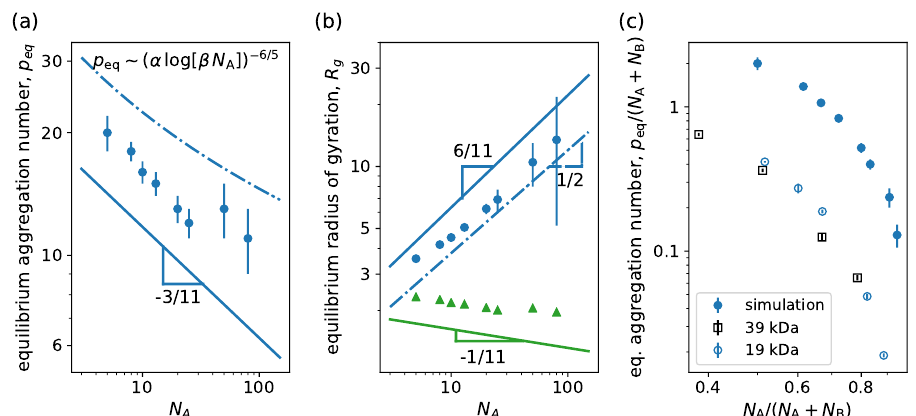
Figure 5. ( a ) Equilibrium aggregation number and ( b ) equilibrium radius of gyration versus degree of polymerization of the hydrophilic block N A . ( c ) Normalized equilibrium aggregation number versus normalized degree of polymerization of the hydrophilic block. We consider linear neutral block copolymers ( g = 0) with N B = 5. Continuous lines correspond to power law behavior predictions from mean-field theory and dash-dotted lines correspond to predictions from scaling theory [42]. In ( b ), circles and triangles are results for micelle and core radii of gyration, respectively, from simulations, while blue and green lines correspond to corona and core size scaling predictions from theory. In ( c ), filled circles correspond to simulation results and empty symbols to experimental data from Ref. [66] for linear block copolymers formed from polystyrene-b-polyisoprene with different lengths of polystyrene block, namely 39 kDa and 19 kDa. Other system parameters: w c = 1.8, (cid:101) attr = 0.6 and k B T =